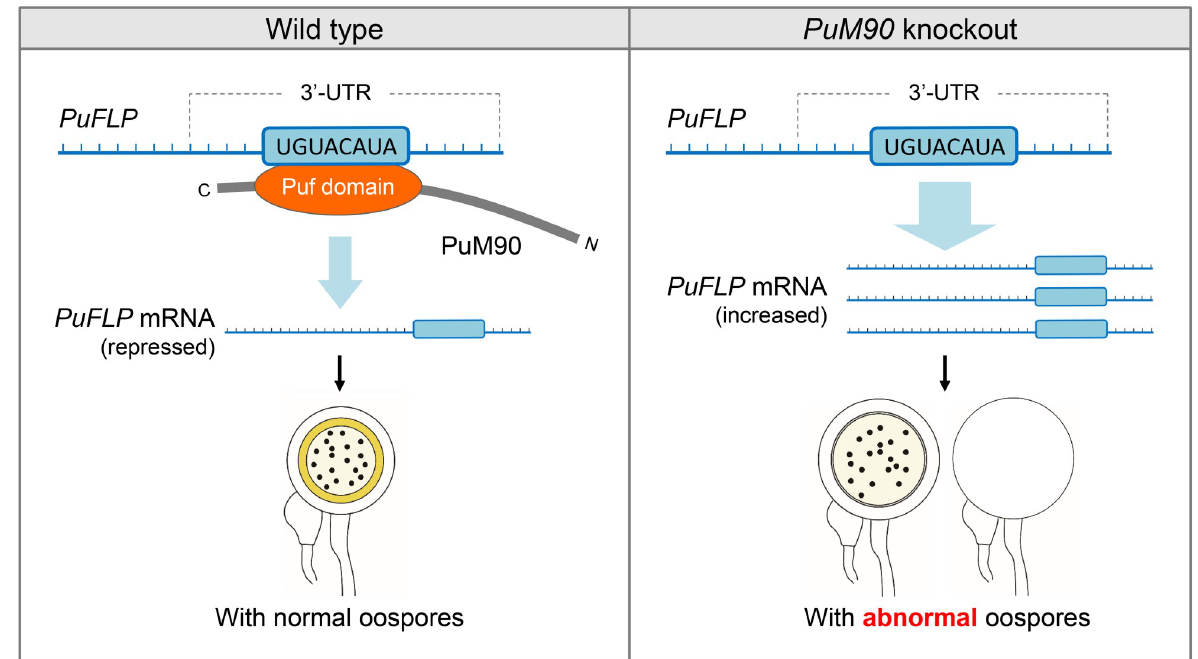
Fig 9. A proposed model for PuM90 function. PuM90 protein could specifically bind to a UGUACAUA motif in the 3 0 -UTR of PuFLP mRNA, as the post-transcriptional way to repress PuFLP mRNA level to facilitate oospore formation. PuFLP is not regulated by PuM90 in PuM90 deletion mutants resulting in increased transcript levels of PuFLP . Exorbitant PuFLP mRNA leads to abnormal oospore. Thus, the RNA-binding protein PuM90 acts as a novel oospore formation regulator to promote the oomycete